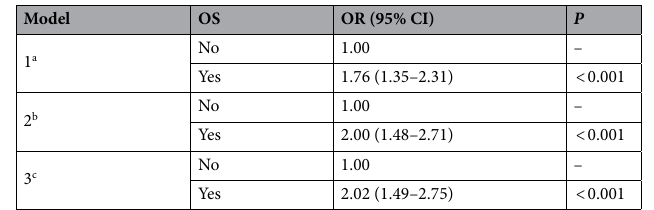
Table 3. Logistic regression analysis of occupational stress and risk of dyslipidemia. a The variables adjusted by